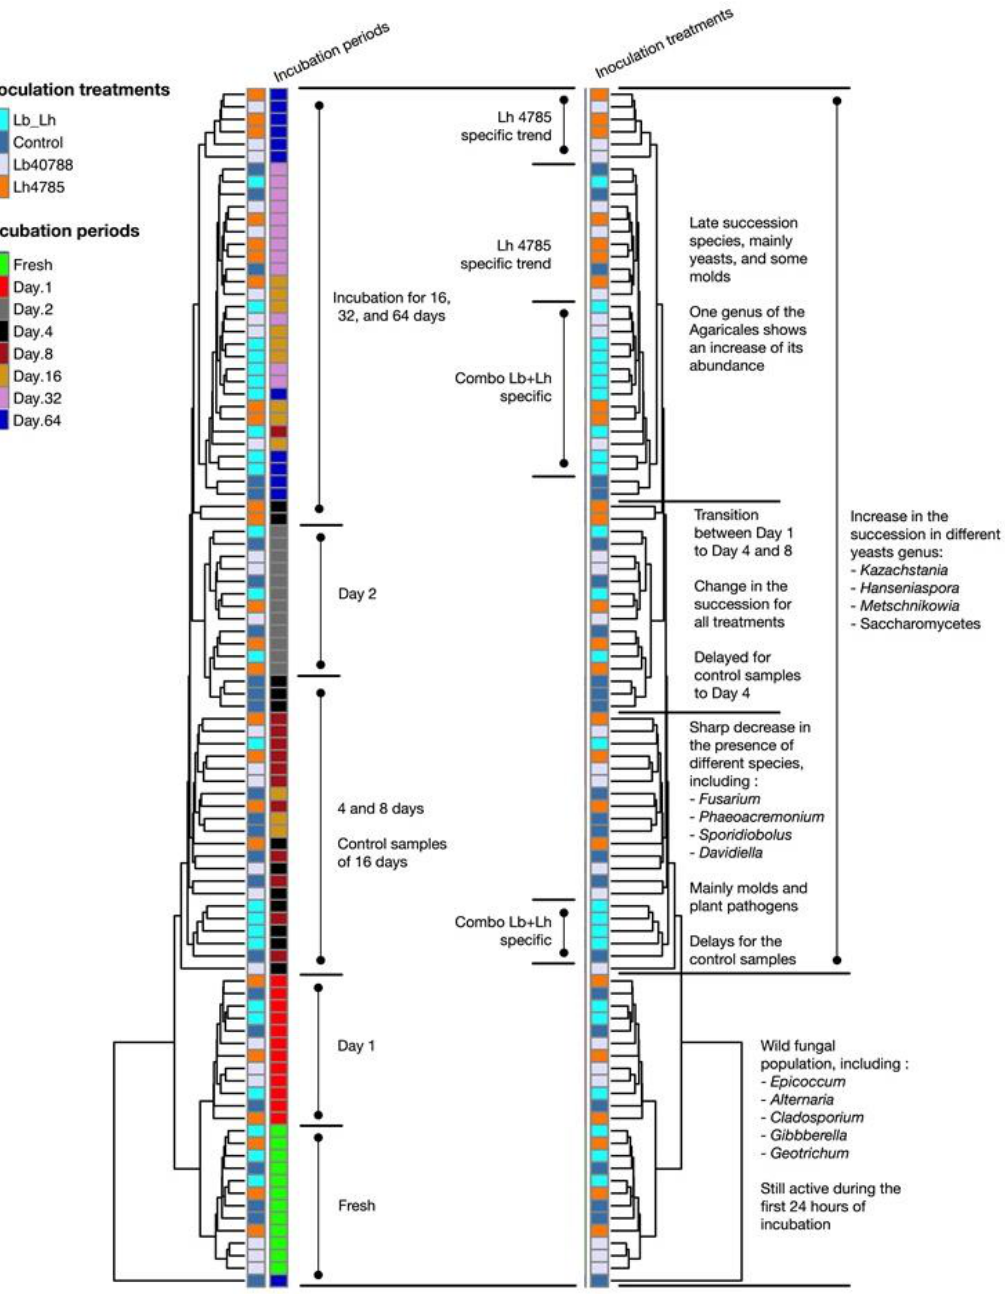
Figure 5. Main changes in fungal diversity using the UPGMA dendrogram generated for analysis of the heatmap (see Figure S4).